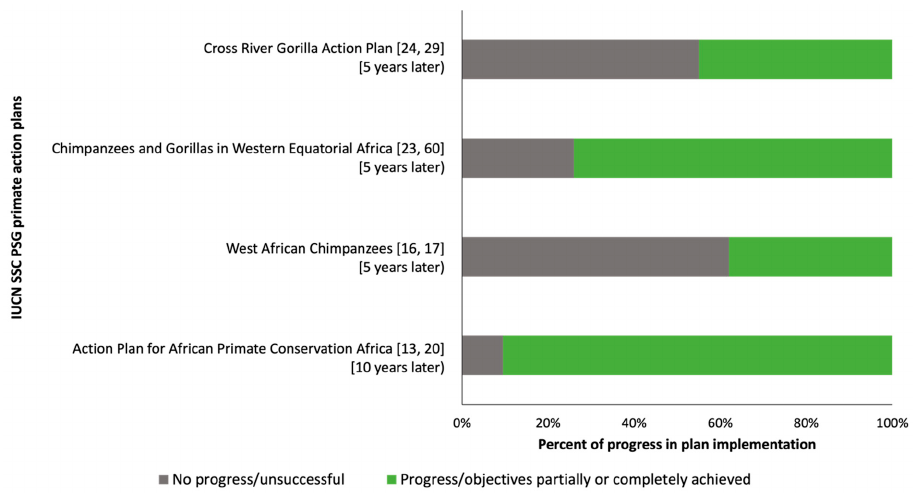
Figure 4. Estimated implementation progress in the years following primate action plan publication, for four primate action plans (see Table S1 for citations). See refs [13,16,17,20,23,24,29,60].